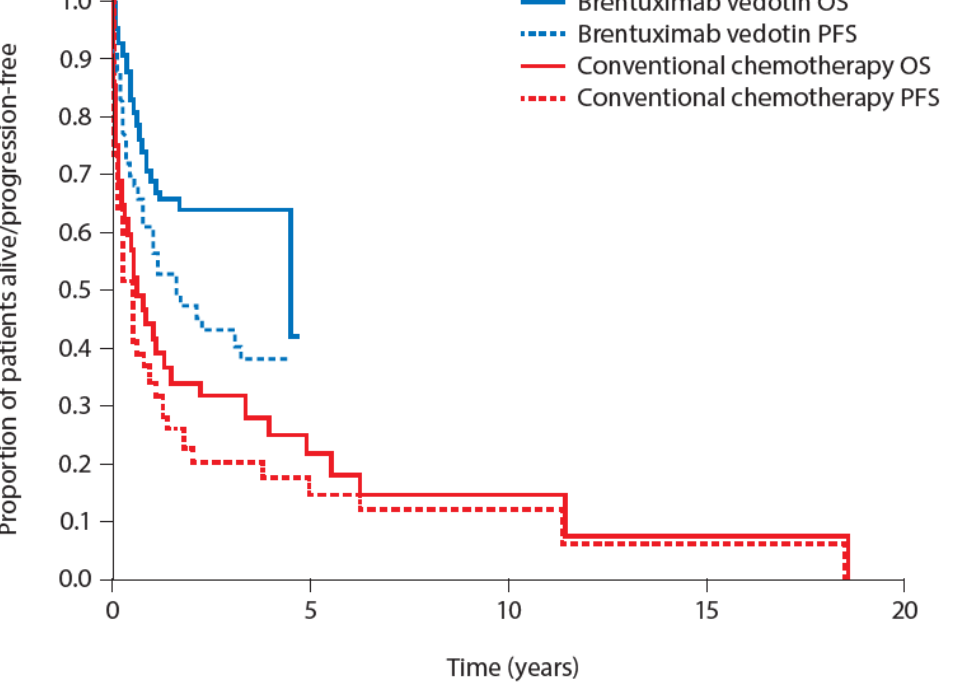
Figure 1. Observed OS and PFS for Brentuximab Vedotin and Conventional